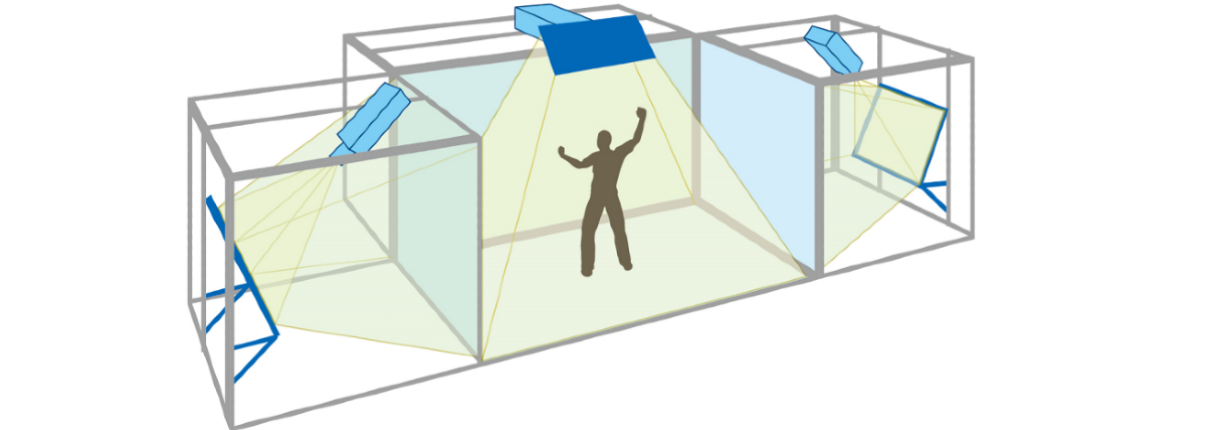
Figure 2. Cave Automatic Virtual Environment (CAVE).